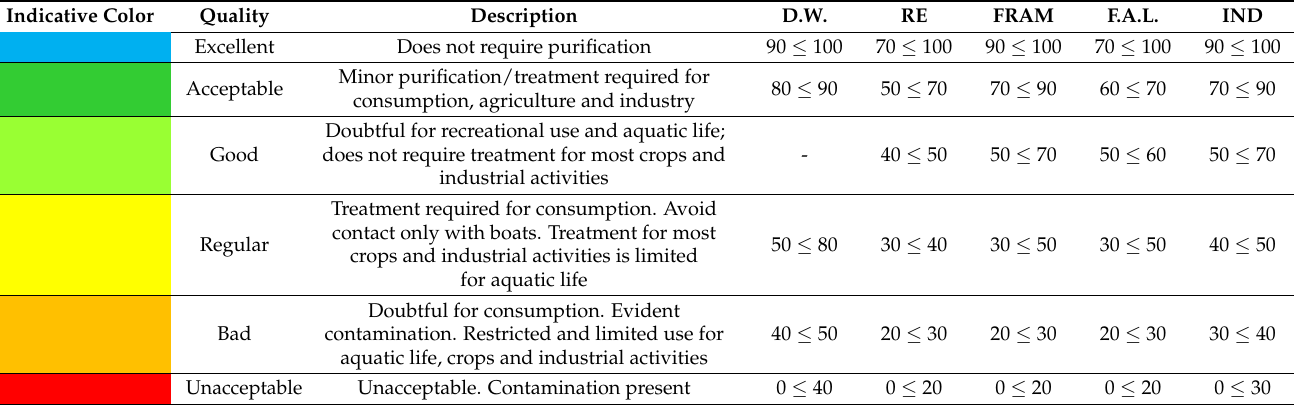
Table 6. Color scale and ranges of the water quality index.